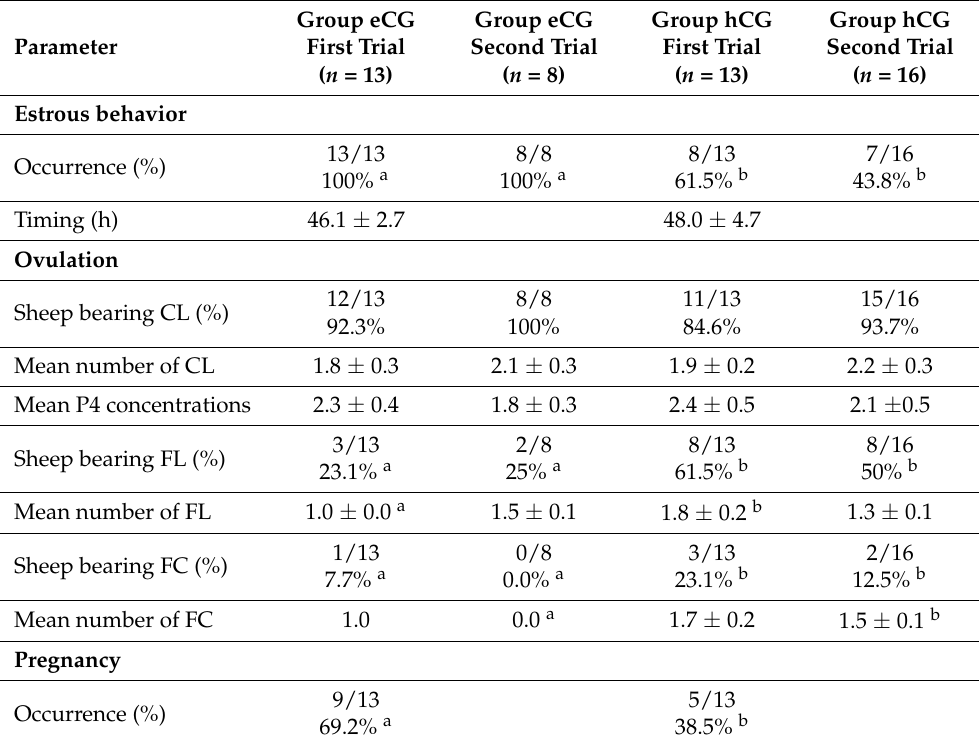
Table 1. Percentage and timing of occurrence of estrus, characteristics of the ovarian response (in terms of corporal lutea (CL), plasma progesterone concentrations (P4), luteinized follicles (FL) and follicular cysts (FC), and pregnancy rate in sheep treated with Controlled Internal Drug Release (CIDR) devices for five days and 400 IU of eCG plus 5 mg of prostaglandin F2 α at CIDR removal (Group eCG) or 500 IU of hCG at 24 h after CIDR removal (Group hCG).